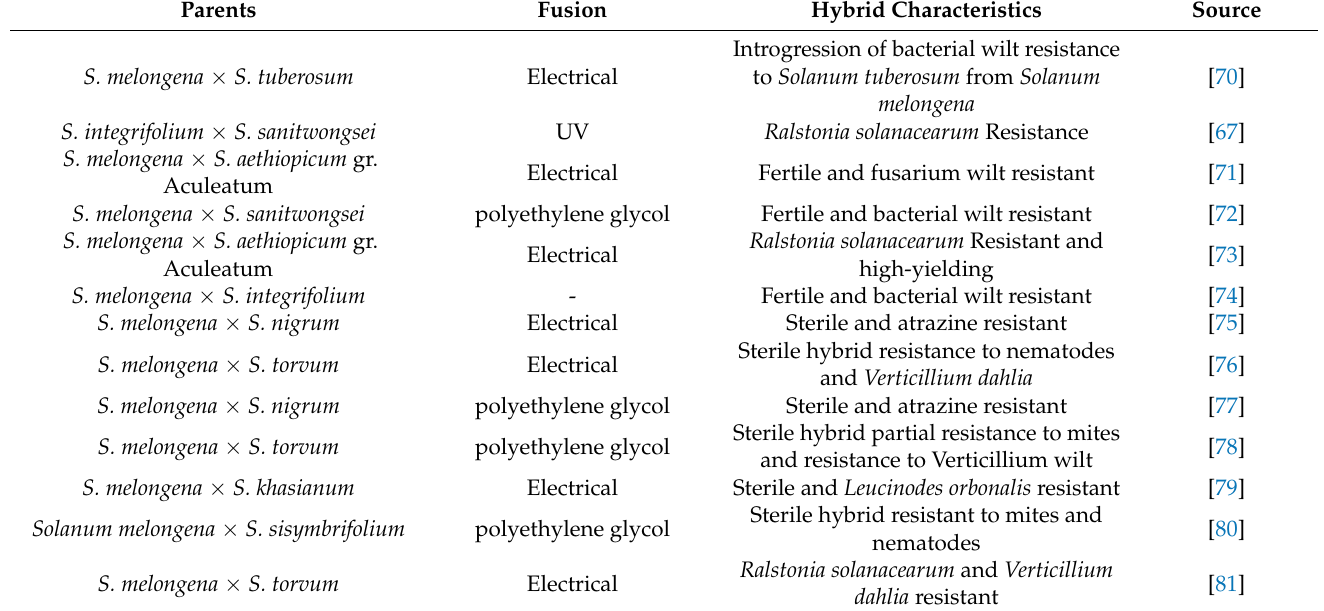
Table 5. Development of somatic hybrids through protoplast fusion in